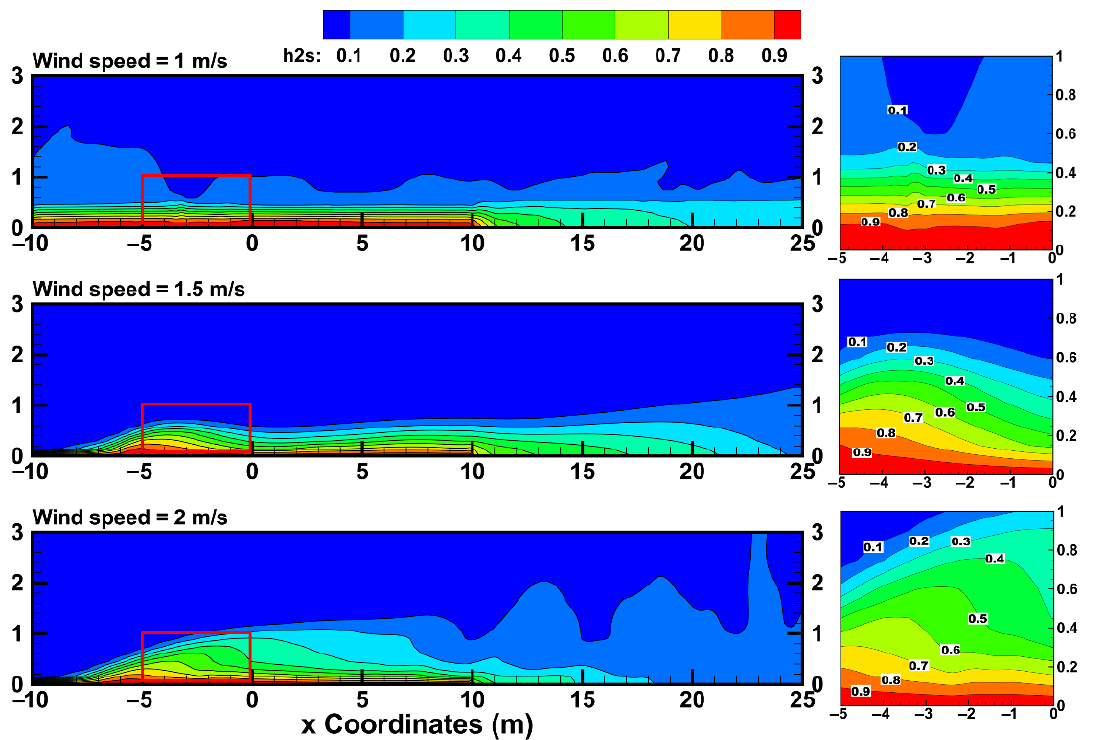
Figure 5. H 2 S plume of wind speed 1 m/s, 1.5 m/s, and 2 m/s, controlling temperature at 298 K. The change of H 2 S concentration fraction revealed the dispersion tendency of H 2